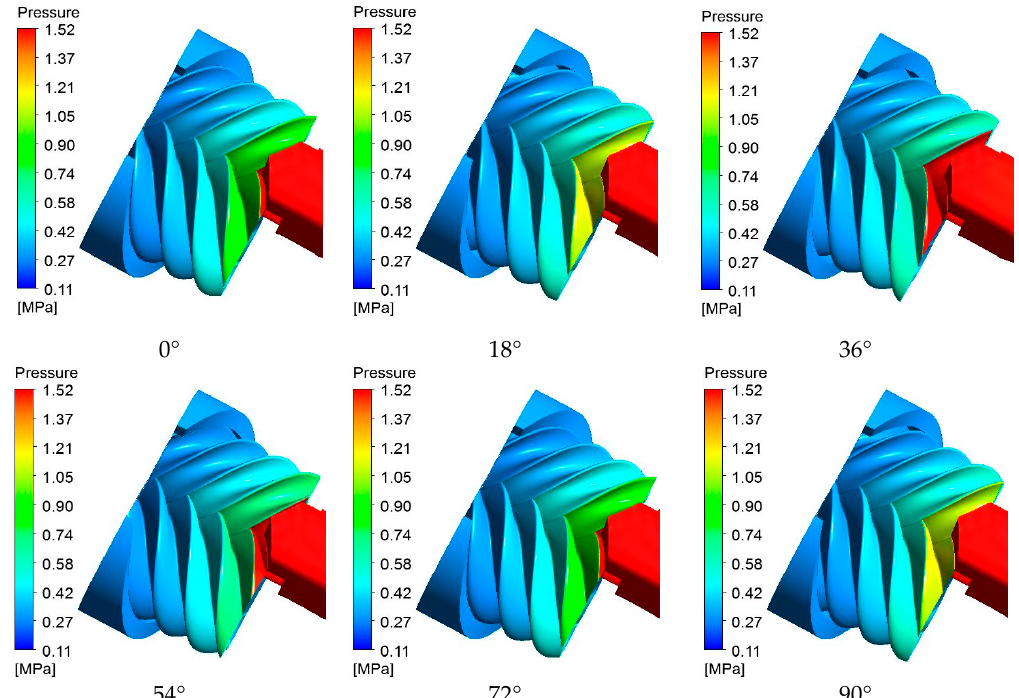
Figure 6. The pressure distribution inside the compressor at different angles.